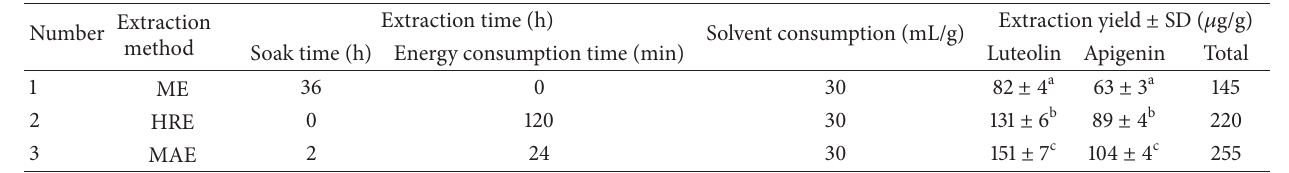
Table 2: Comparison of MAE with other extraction methods, mean ± S.D ( 𝑛 = 3